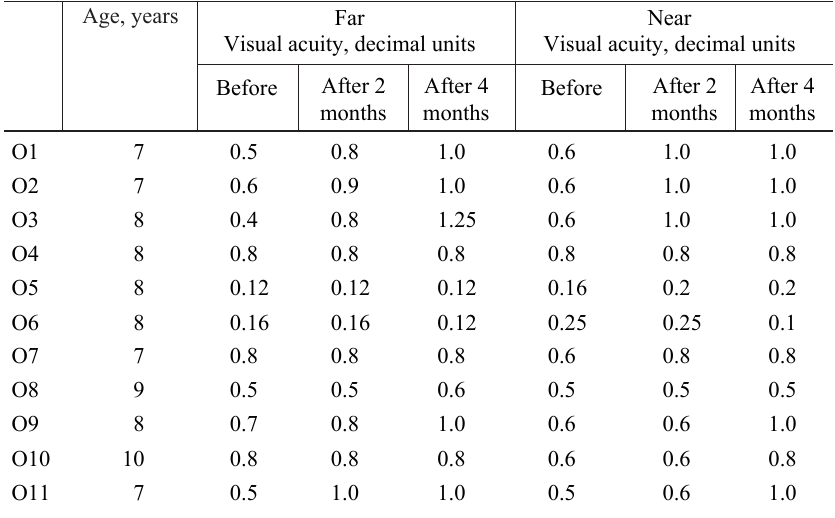
Table 1. Visual acuity evaluation results for far and near in participants with occlusion therapy before, 2 months and 4 months after the beginning of amblyopia